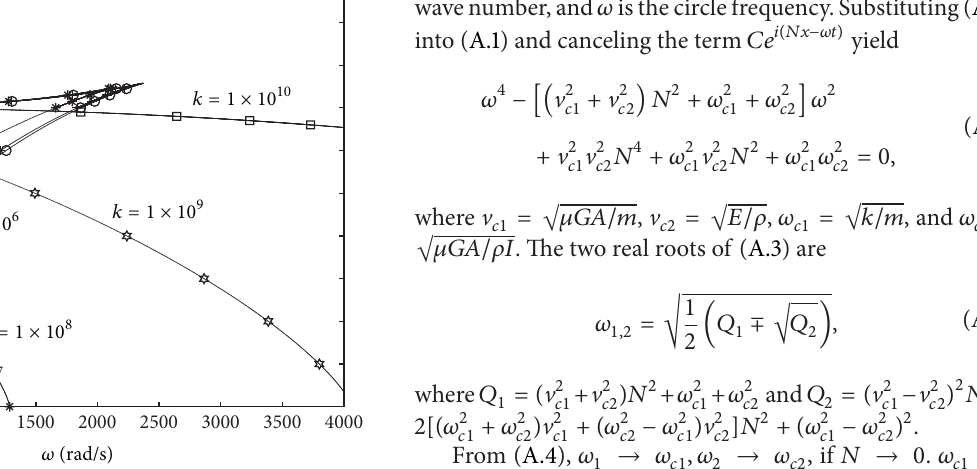
versus loading frequency 𝜔 for cr